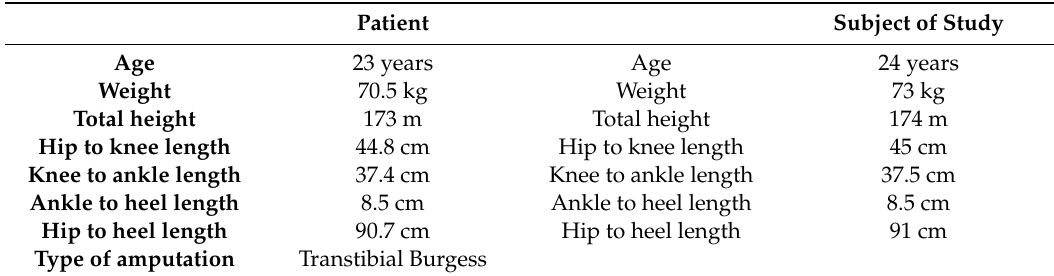
Table 1. Anatomical data of the patient and test subject.